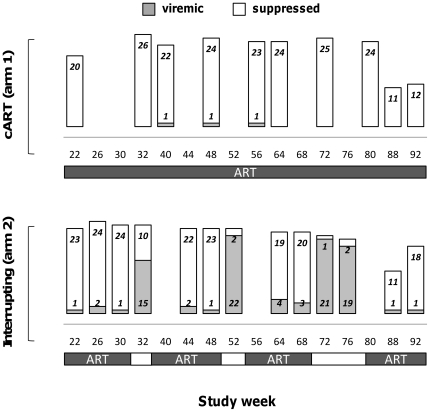
Visit viral load count outcomes.Stacked bars and numbers represent the number of subjects with HIV RNA<50 copies/ml (suppressed, closed bars) and ≥50 copies/ml (viremic, open bars) at each post-randomization visit are reported for the control continuous treatment arm (top panels, cART) and the ART-interrupting arm (bottom panel, interrupting). The treatment line below the graphics represent the time on and off ART for each study.